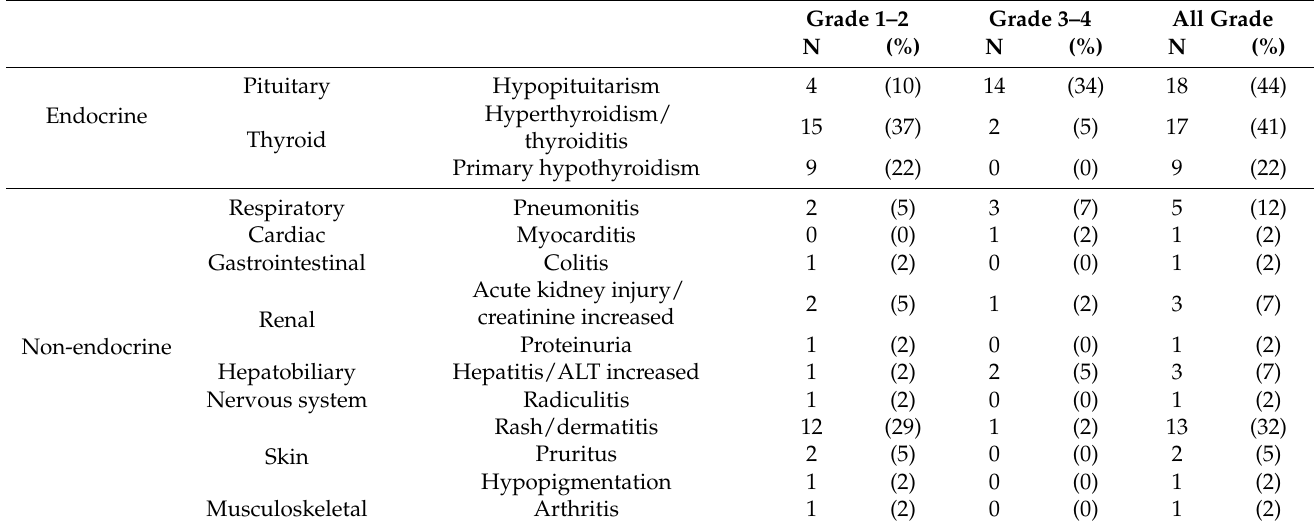
Table 2. The number and grades of irAEs following nivolumab plus ipilimumab therapy.